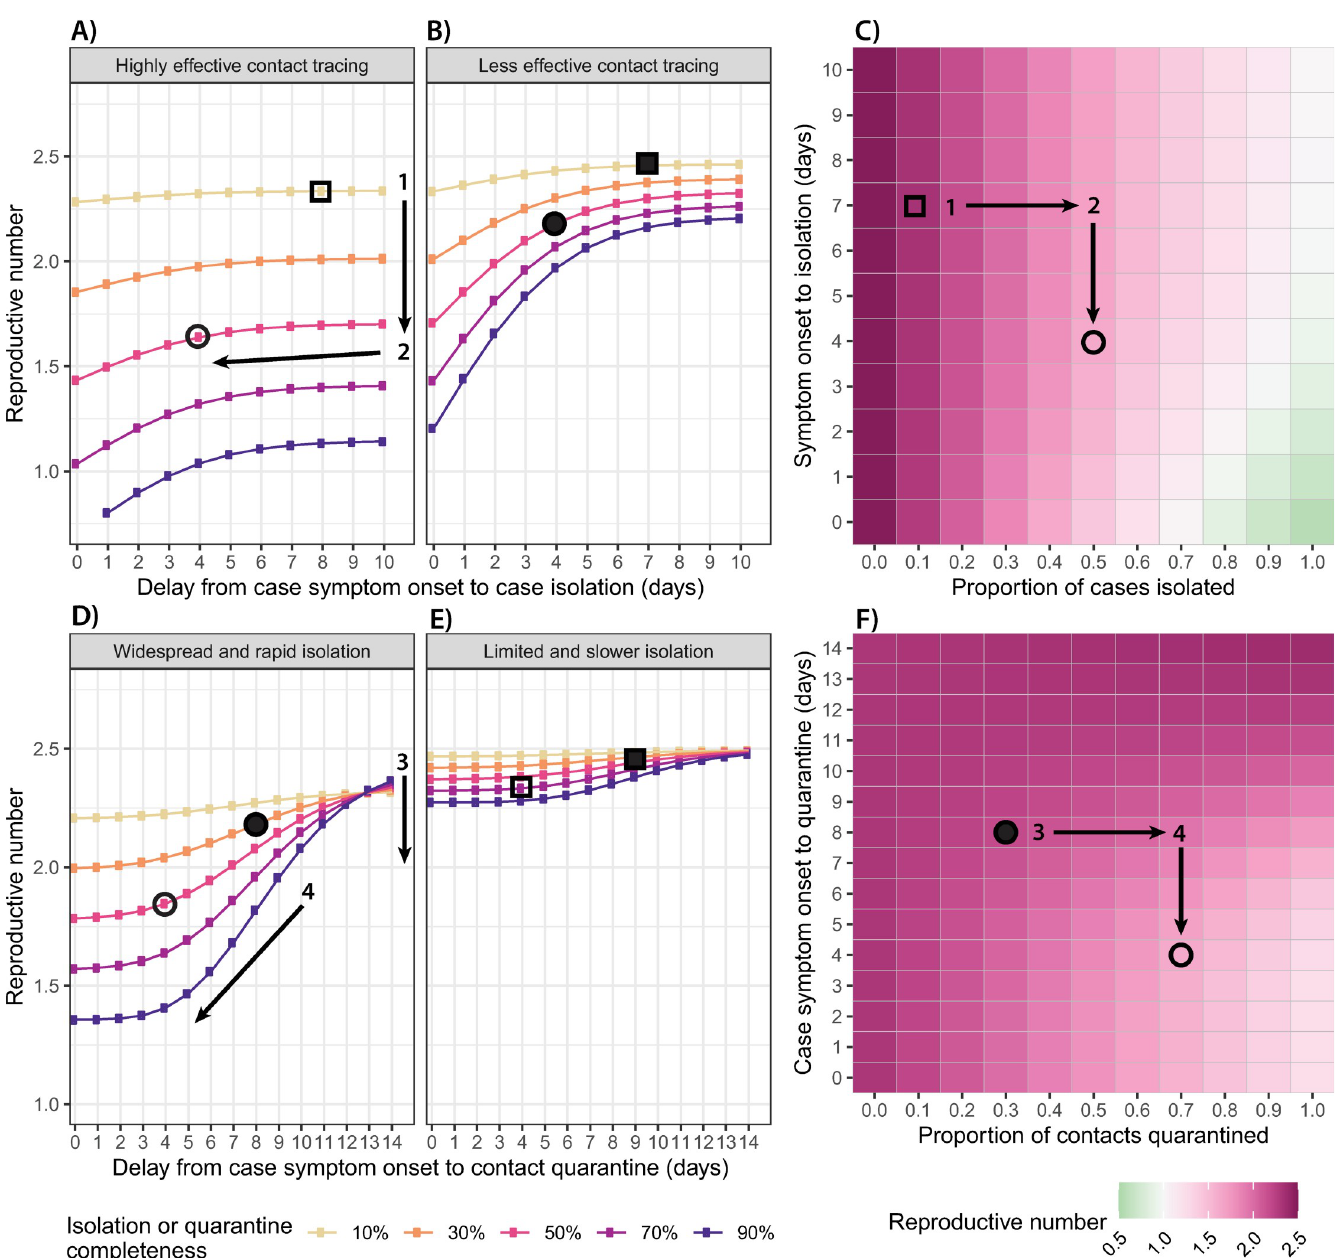
Fig 3. Improvements to case isolation and contact quarantine : Impact of case isolation timing (x-axis) and completeness (line colors) on the effective reproductive number (y-axis) for (A) a highly effective contact tracing program and (B) a less effective contact tracing program. (C) Heat map of the effective reproductive number across a range of case isolation timing (y-axis) and completeness (x-axis) scenarios, assuming that contact tracing is highly effective. Impact of contact tracing timing (x- axis) and completeness (line colors) on the effective reproductive number (y-axis) for (D) a widespread and rapid case isolation scenario and (E) a less effective and slower case isolation scenario. (F) Heat map of the effective reproductive number across a range of contact tracing timing (y-axis) and completeness (x-axis) scenarios, assuming that detection and isolation of index cases is widespread and rapid. For all panels, the open shapes mark example scenarios with highly effective contact tracing (70% quarantined on average 4 days after case symptom onset) in contrast to the filled shapes of a less effective contact tracing scenario (30% quarantined after 8 days). Circles mark example scenarios with widespread and rapid case isolation (50% isolated on average 4 days after case symptom onset) in contrast to squares, which have limited and slower case isolation (10% isolated after 7 days). Shapes display consistent scenarios across all panels in the figure.